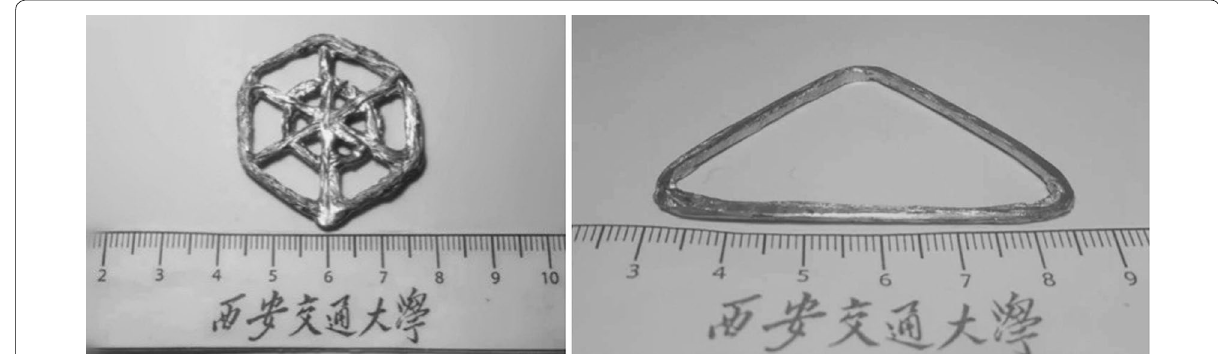
Figure 11 A hexagonal grid and a triangle grid printed by FTP